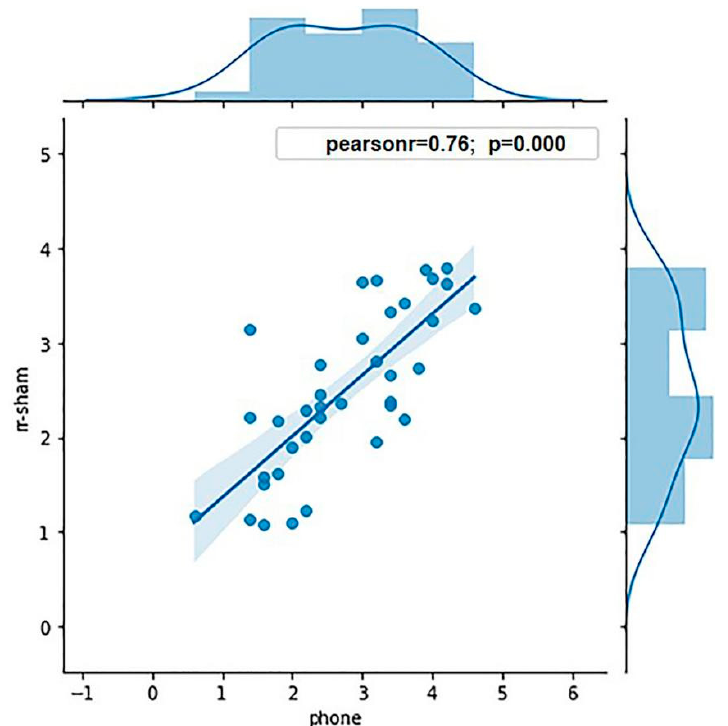
Figure 3. The correlation of the K value measured by the mobile phone and in the sham stimulation condition in this experiment.